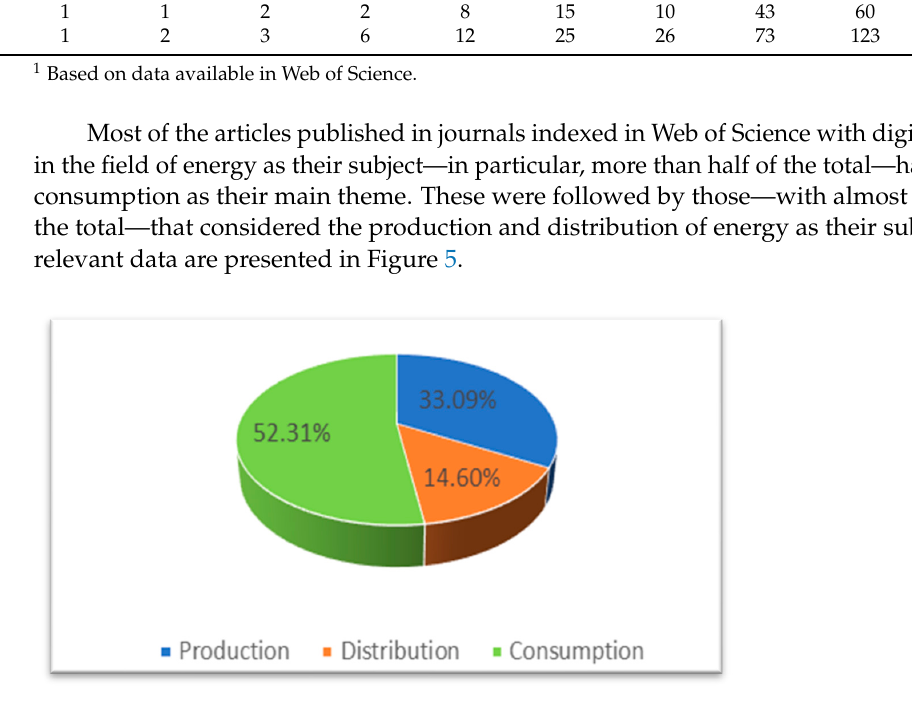
Figure 5. Sectoral distribution of articles published in the Web of Science database on the topic of digitalization in energy.